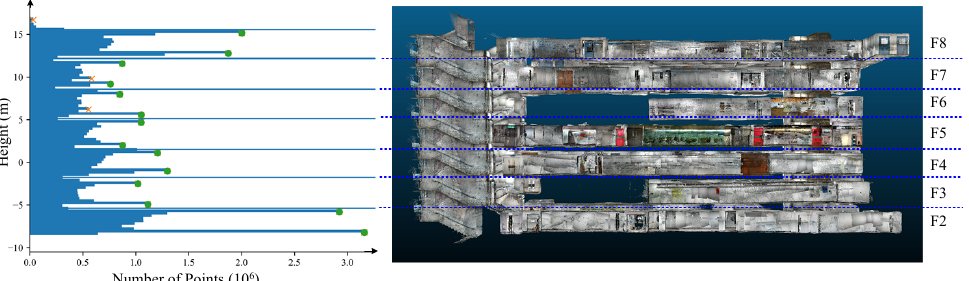
Figure 4. Separation of stories in the point cloud, where the green dots are the detected floor and ceiling heights, and the red crosses are the peaks filtered